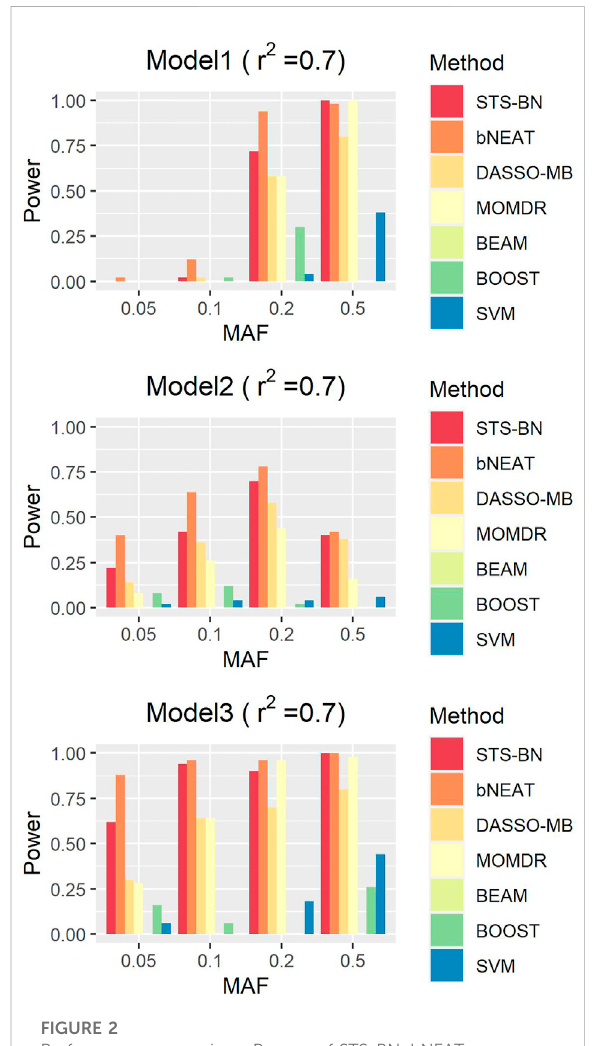
FIGURE 2 Performance comparison. Powers of STS-BN, bNEAT, DASSO-MB, MOMDR, BEAM, BOOST, SVM. (r 2 = 0.7).